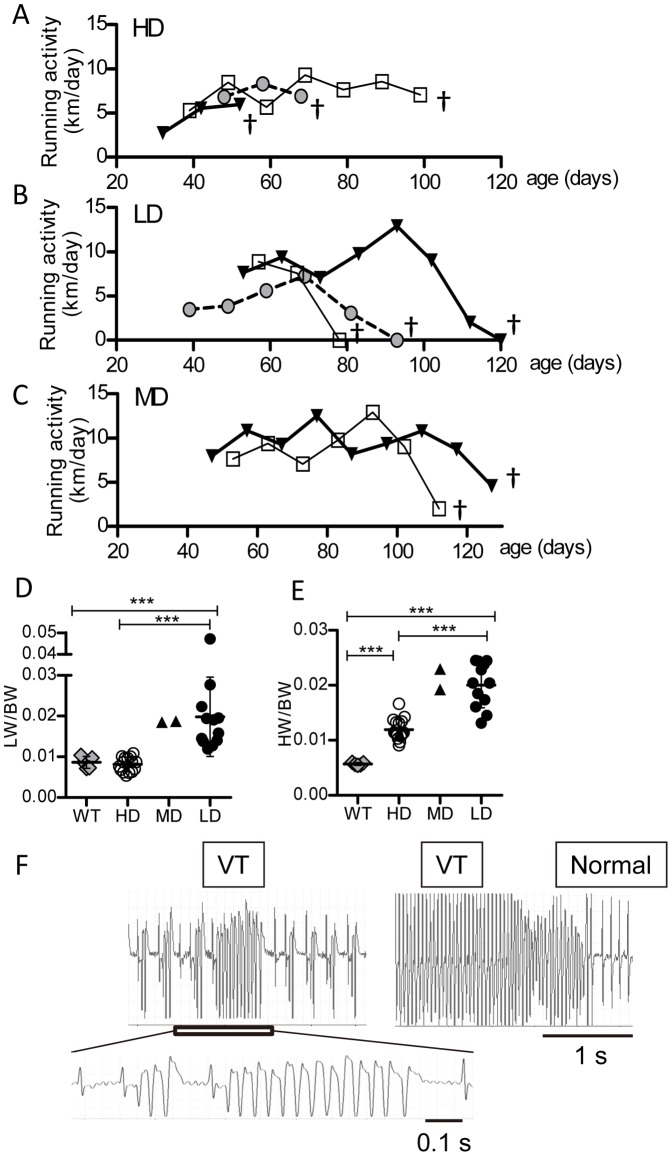
Time courses of voluntary running activity and causes of death in DCM mice.
A. Typical time courses of running activity in three mice that maintained high activity (>5 km/day) and died suddenly. B. Instances of three mice that decreased running activity to <1 km/day and died. C. Instances of two mice that gradually lost running activity to between 1 and 5 km/day and died. Different symbols indicate different individual mice. D and E
. LW/BW (D) and HW/BW (E) ratios in mice found dead in their cage. HD: mice with running activities of >5 km/day before death (n = 15). MD: mice that showed last running activity between 1 and 5 km (n = 2). LD: mice with activity of <1 km/day before death (n = 12). Bars are mean±SD. *P<0.05, **P<0.01, ***P<0.001. F. Typical ventricular arrhythmia recorded with telemetry ECG system from a 2.5-month-old mouse with high wheel running activity. Inset: ECG record with expanded time scale. Ventricular tachycardia (VT) repetitively occurred for 15 min in this mouse.